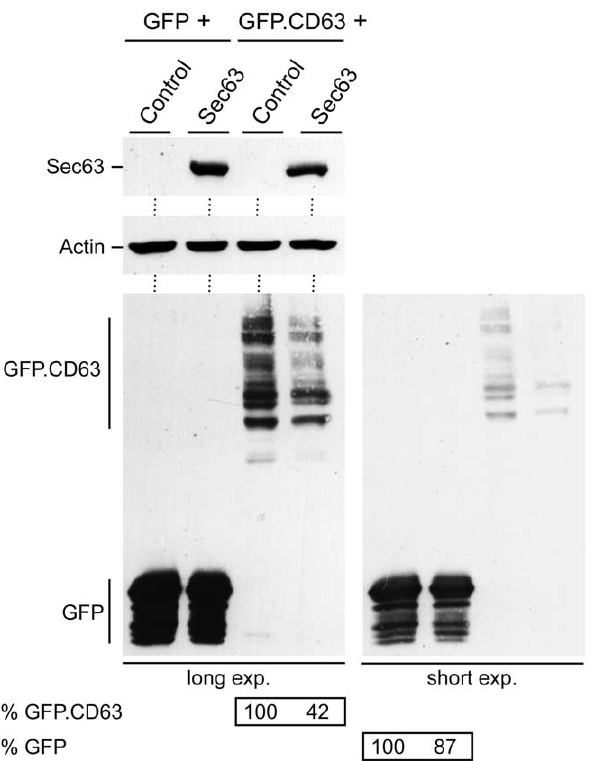
Figure 7. Overexpressing of Sec63 reduces the cotranslational insertion of GFP.CD63 without grossly affecting the translation of GFP. HuH-7 cells were transfected with GFP or GFP.CD63 together with control DNA or Myc-tagged Sec63, as in Fig. 5. Cell extracts were prepared by a 15 minutes boiling in SDS sample buffer and probed by anti-Myc (top), anti- b -actin (middle), and anti-GFP (bottom) WB. Long and short exposures of the GFP-specific blot plus quantification data are